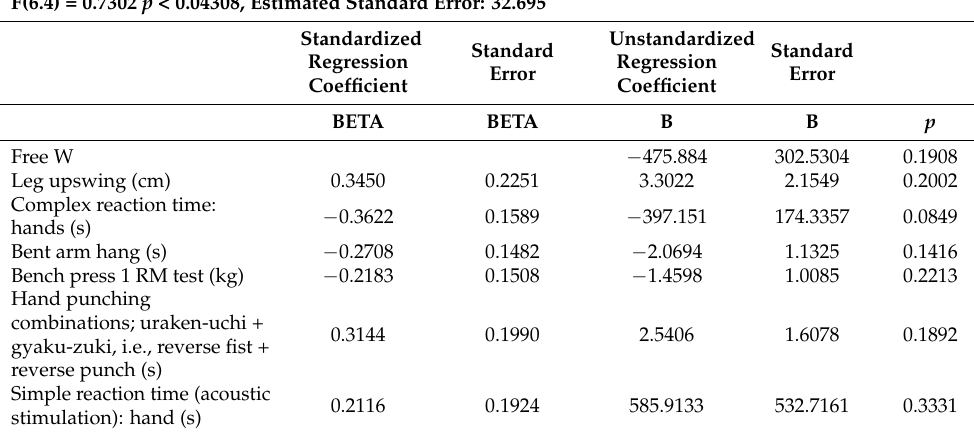
Table 9. Summary details of the lambda ridge regression from the 2nd study stage for male partici- pants; dependent variable = ranking